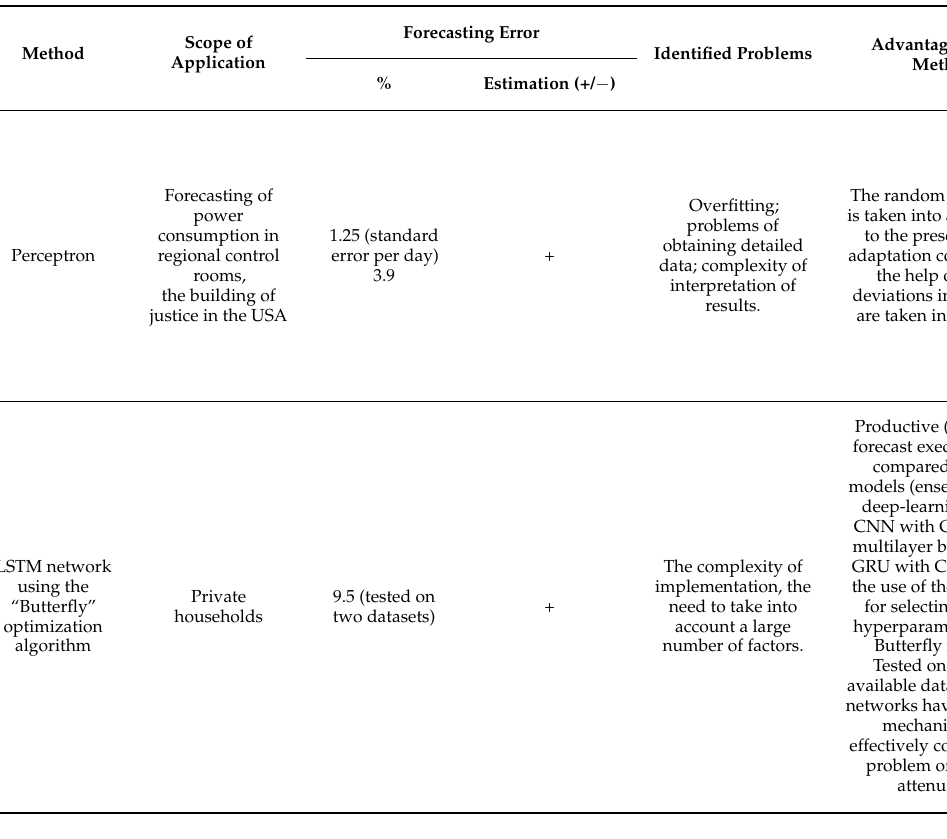
Table 1. Analysis of methods used in operational forecasting of power